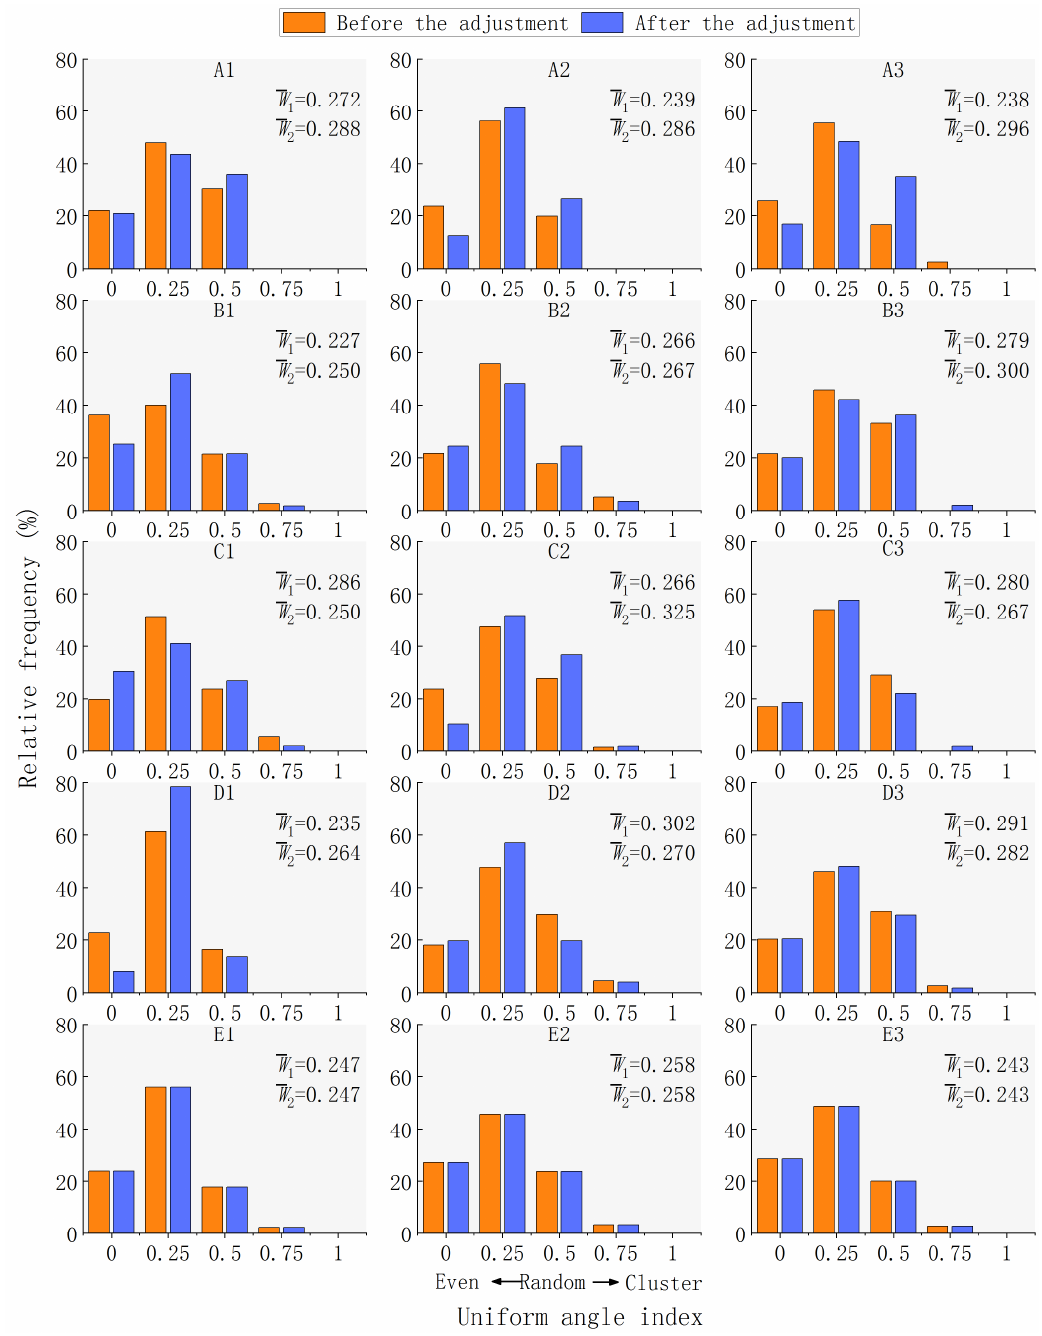
Figure 4. Uniform angle index distribution of stands with different management modes. Note: W 1 and W 2 represent the mean value of the uniform angle index before and after stand adjustment, respectively. A1–C3 indicates randomized management, D1–D3 indicates underlayer tending, and E1–E3 indicates unmanaged control.